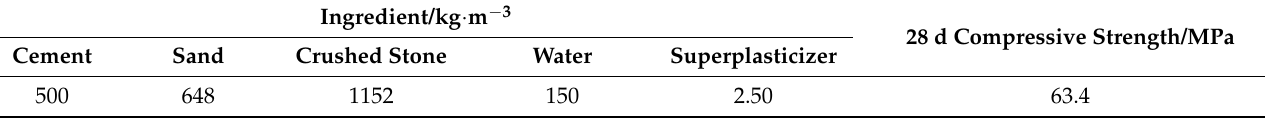
Table 2. Mix proportions of the